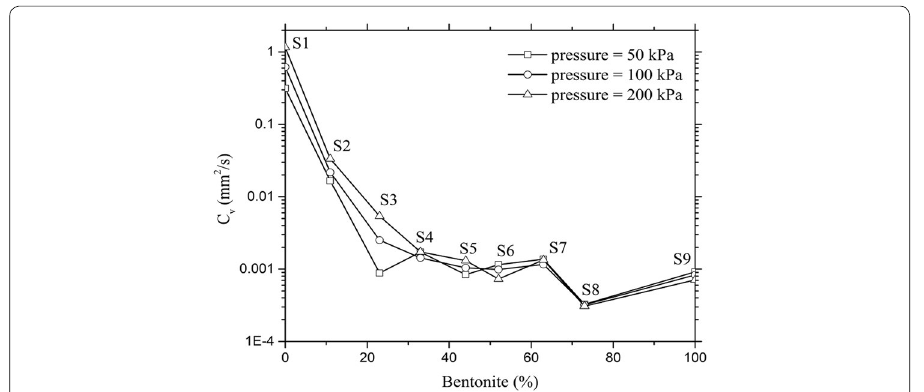
Fig. 6 Effect of bentonite content on the c v values